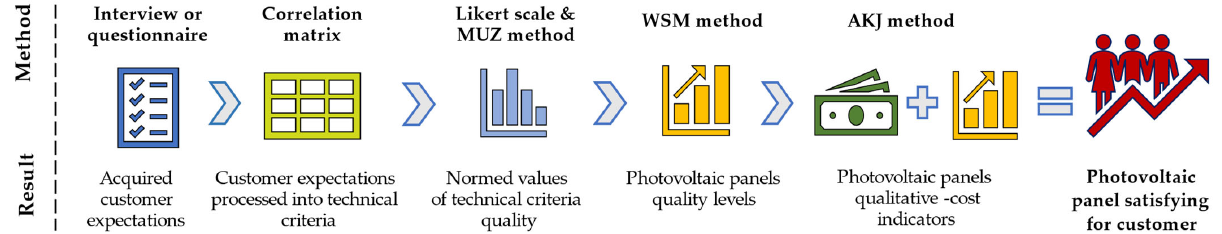
Figure 1. Simplified scheme of selection of methods to proposed model. Own study.